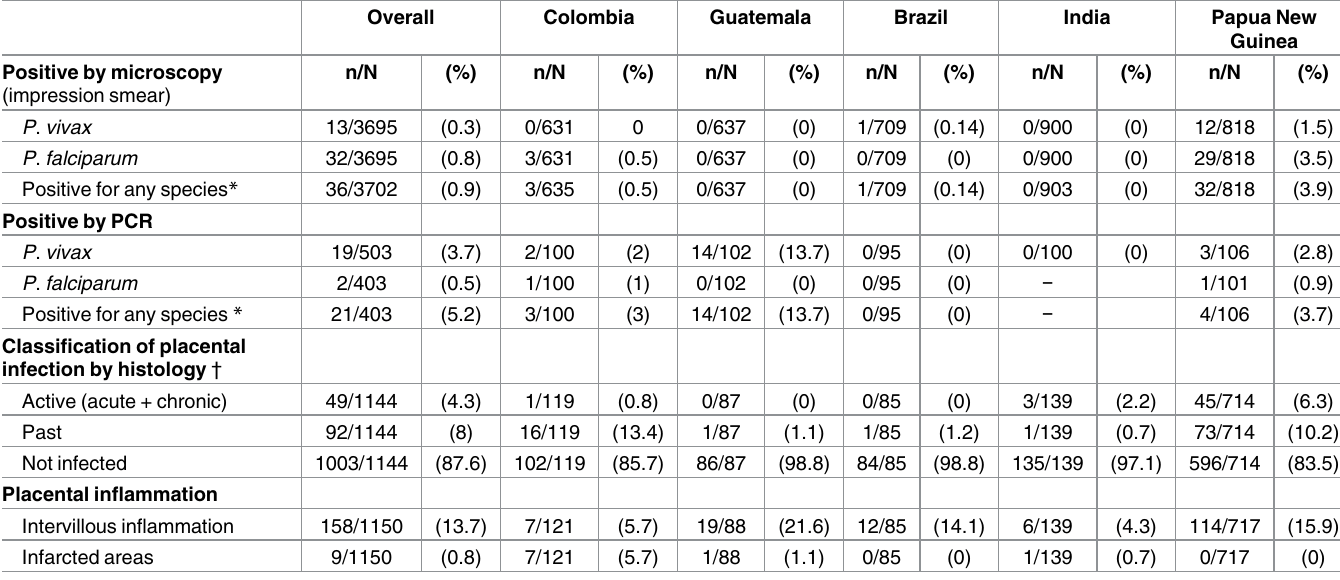
Table 3. Malaria infection in the placenta.